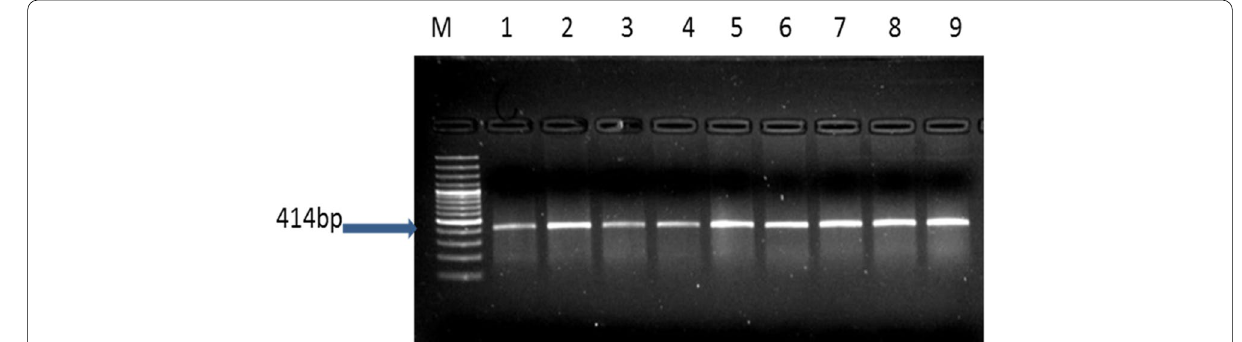
Fig. 6 PCR product of BMP4 gene, M: 100 bp ladder, lanes 1–9: fertile and repeat breeder buffaloes